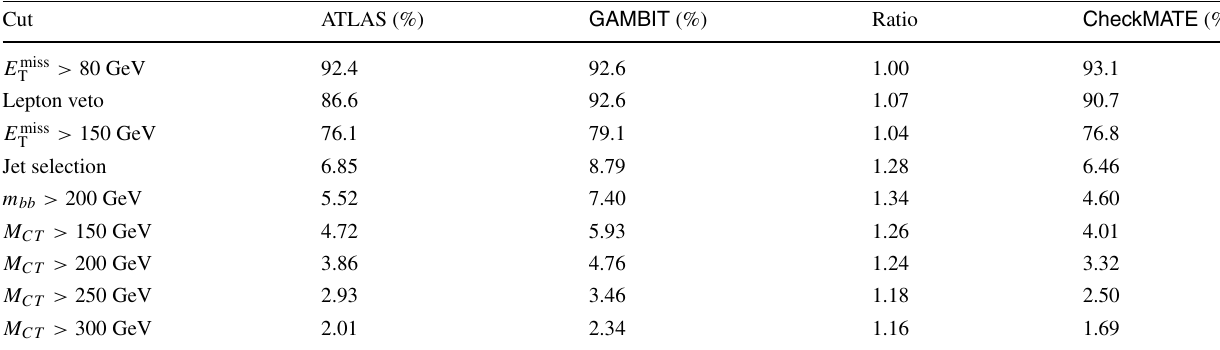
Table 4 The published ATLAS cutflow for SRA in Ref. [43], a search pared with the GAMBIT cutflow obtained using Pythia8 and Buck- Fast . Shown are the percentages of the initial event sample after each fornewphysicsineventswithtwo b jetsandmissingtransversemomen- cut,andtheratioofthe GAMBIT andATLASnumbers.Wealsoprovide tum. The cutflow is generated for a bottom squark pair-production sim- the CheckMATE cutflow in the final column, taken from their public plified model (in which a pair of bottom squarks is produced with direct validation decay to a b -quark and a lightest neutralino, all other sparticles being = 500 GeV and m = 1 GeV. This is com- decoupled), with m ˜ ˜ χ 0 b 1